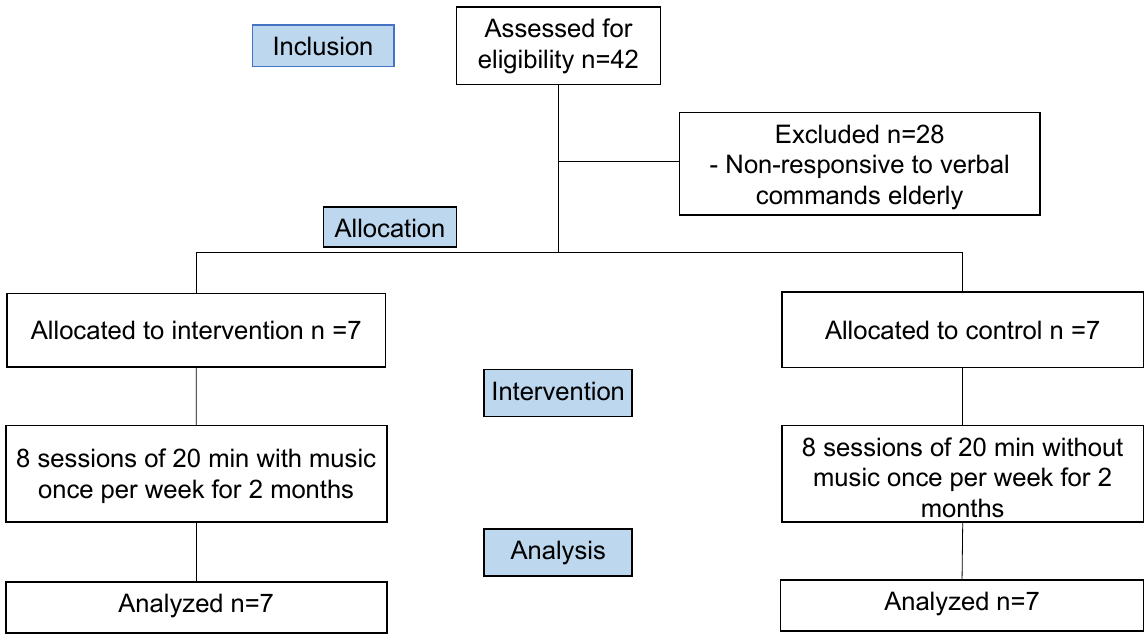
Figure 1. Participant allocation flowchart. São Carlos, SP,